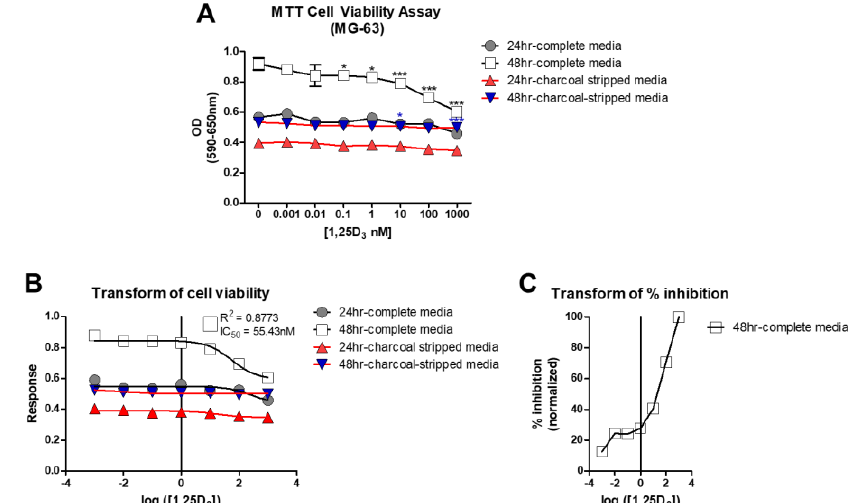
Figure 1. ( A ) The impact of 1,25D 3 on MG-63 cell viability using the 3-(4,5-dimethylthiazol-2-yl)-2,5 diphenyl tetrazolium bromide (MTT) assay. The MTT (3-(4,5-dimethylthiazol-2-yl)-2,5- diphenyltetrazolium bromide) assay was performed in experiments with complete serum or charcoal- stripped serum supplementation for 24 and 48 h of incubation. The cells were treated with one